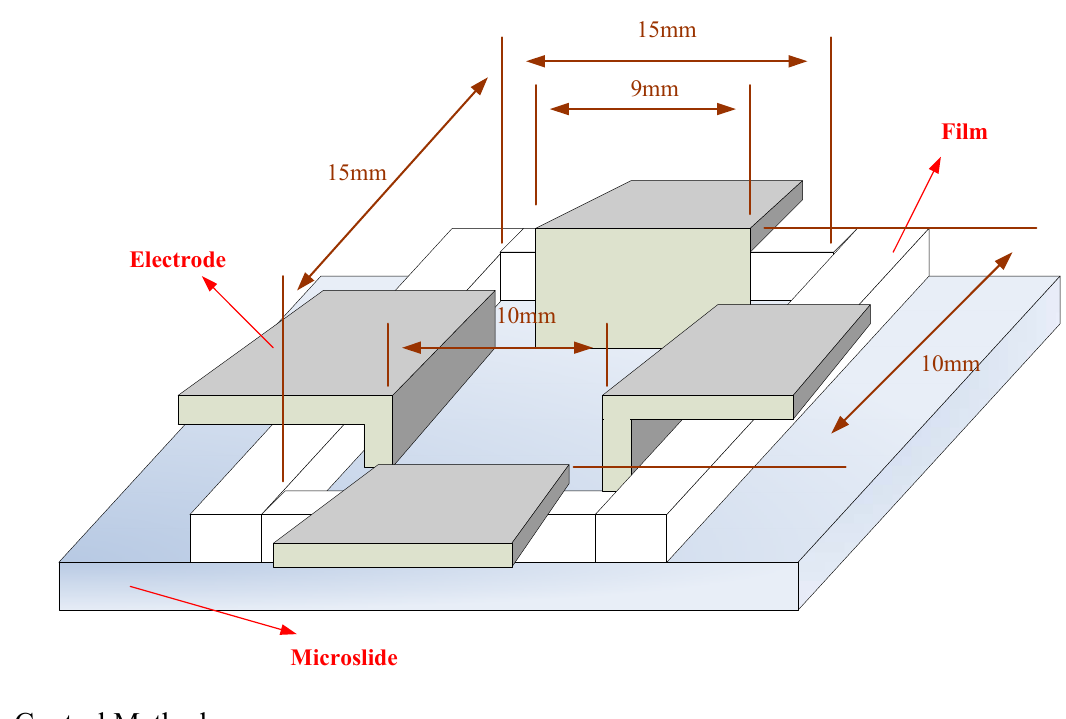
Figure 8. Schematic diagram of electroosmotic